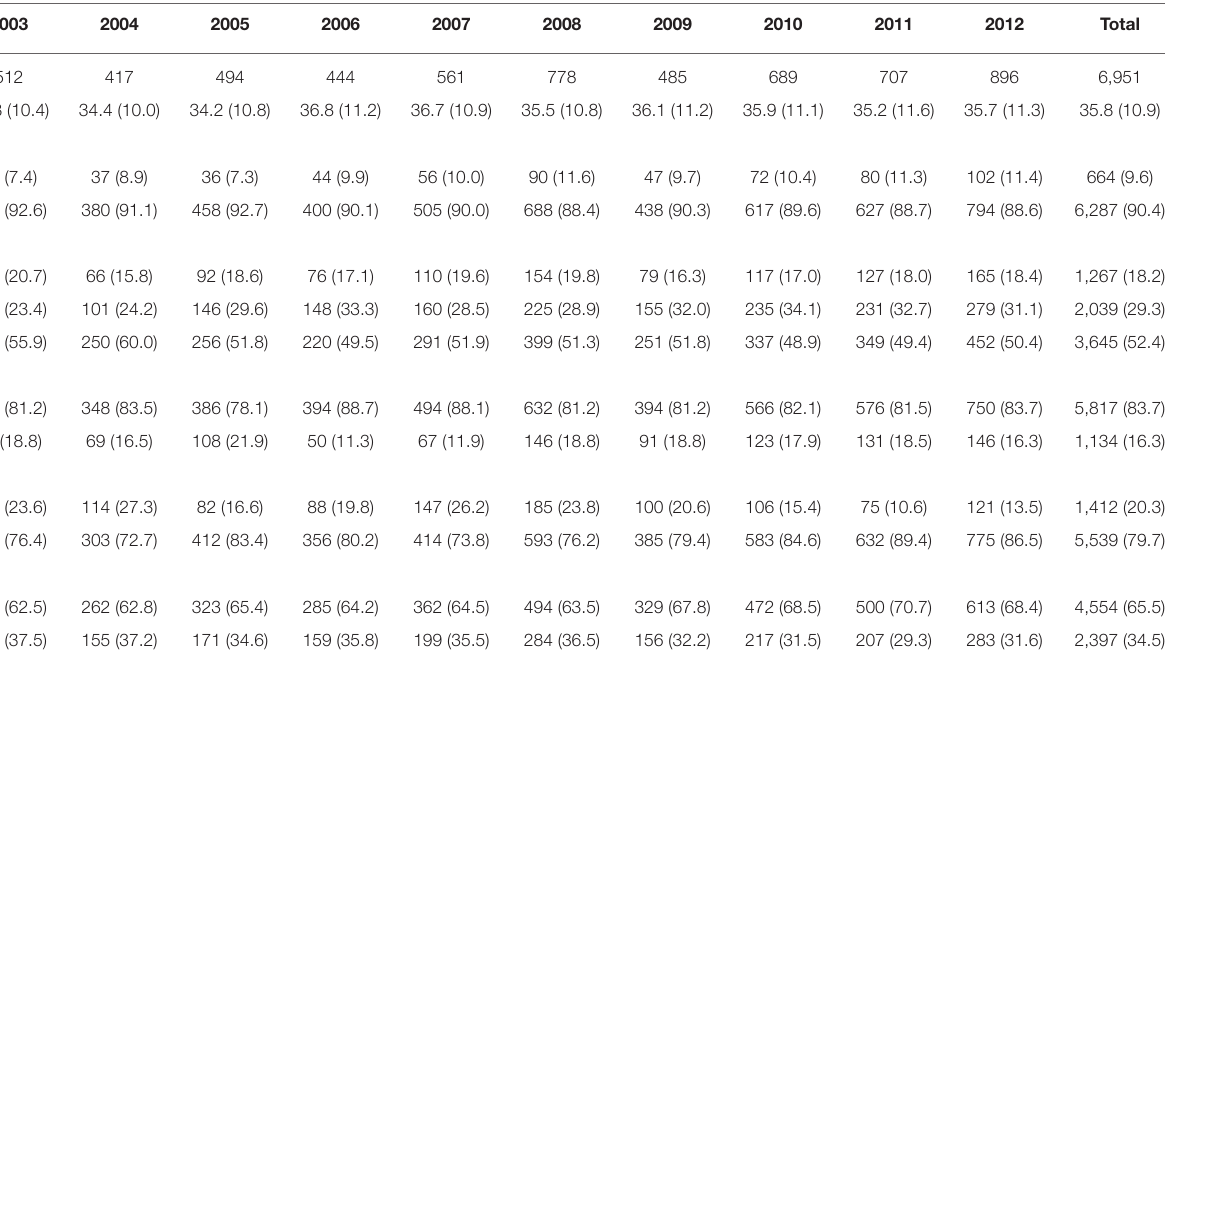
TABLE 1 | Study population